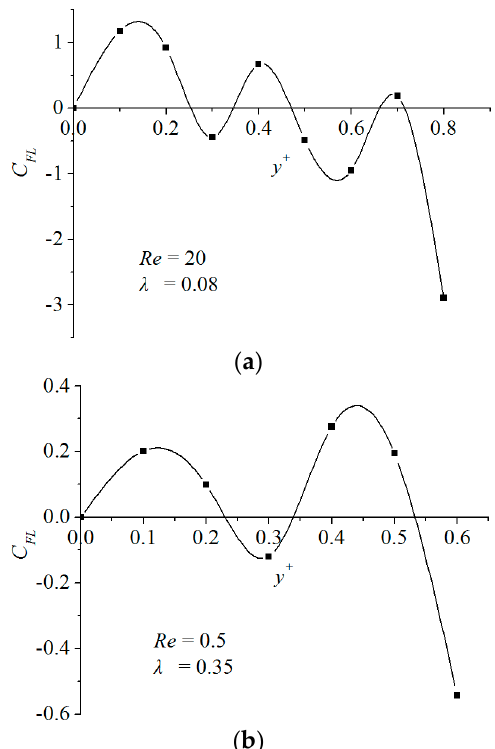
Figure 3. Transverse distributions of the inertial lift force: ( a ) is for smaller particle and ( b ) is for lower Re.